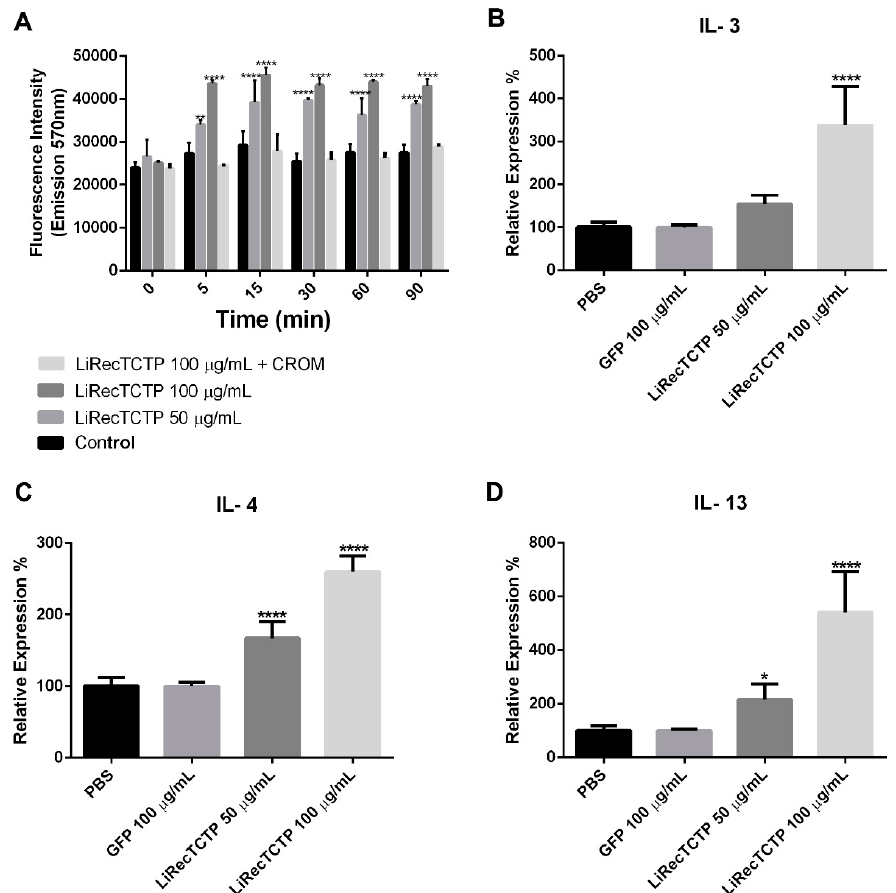
Figure 3. Effect of treatment of RBL-2H3 cells with LiRecTCTP on calcium influx and expression of interleukins. ( A ) RBL-2H3 cells were incubated with LiRecTCTP (50 and 100 µg/mL) in the presence of Fluo-4 AM in buffer containing calcium. The fluorescence of Fluo-4 was measured after 0, 5, 15, 30, 60, and 90 min. As a negative control, cells were incubated without LiRecTCTP. Cromolyn (CROM) (20 µM) inhibitory effect was evaluated in the presence of LiRecTCTP (100 µg/mL). The values represent the average of the three experiments ± s.d. ( ** p < 0.01 and **** p < 0.0001). ( B ) Quantitative real-time PCR of IL-3 mRNA levels in RBL-2H3 exposed or not to LiRecTCTP (50 and 100 µg/mL). ( C ) Quantitative real-time PCR of IL-4 mRNA levels in RBL-2H3 exposed or not